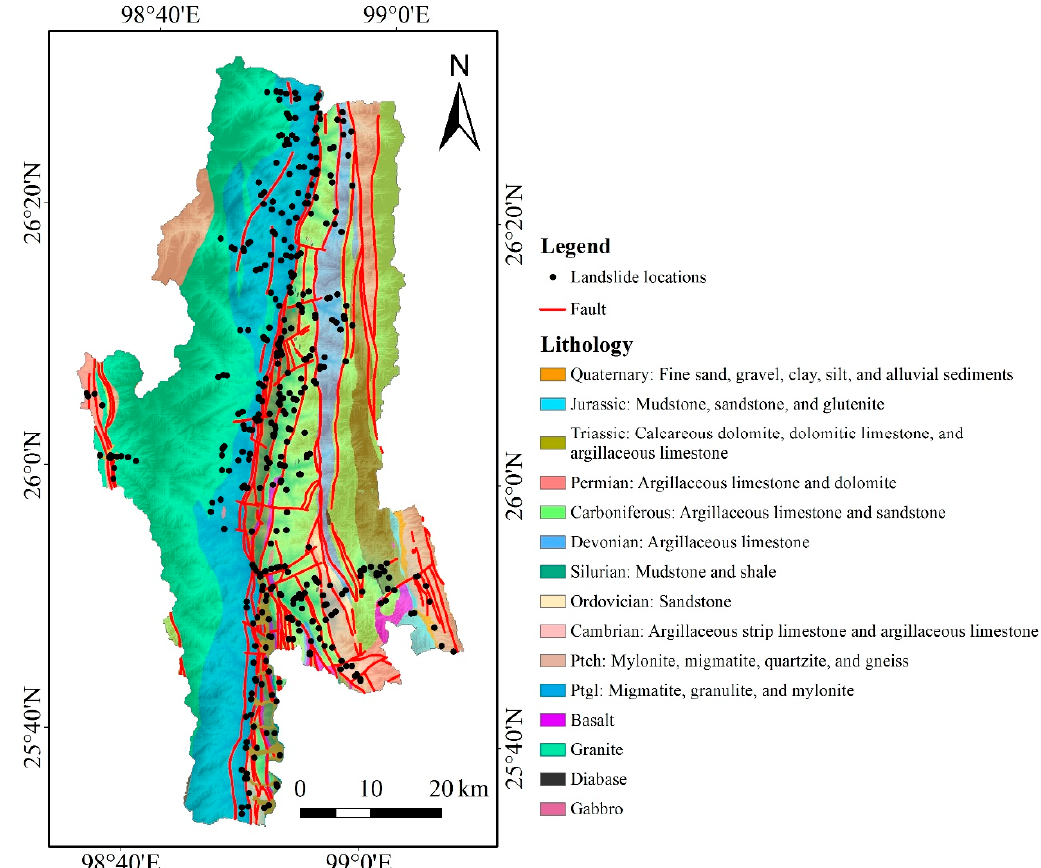
Figure 2. Geological map of the study area.